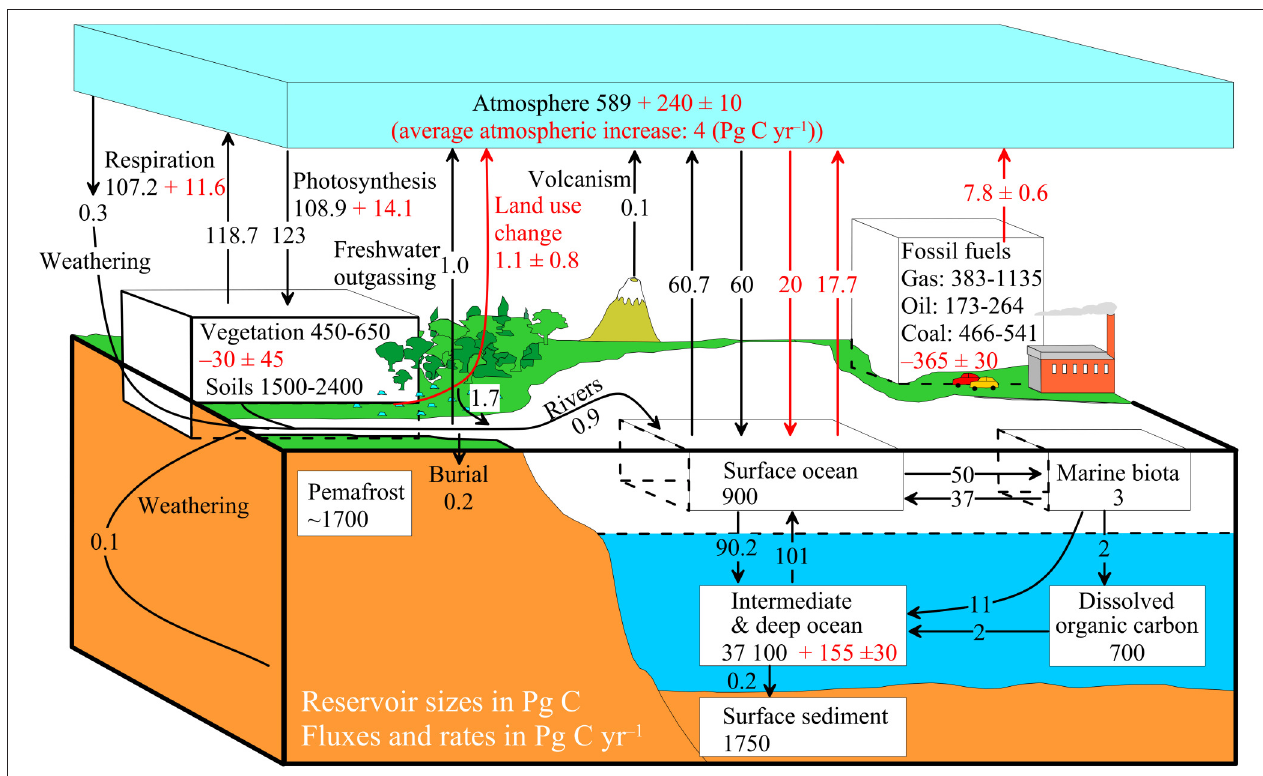
FIGURE 1 | Simplified diagram of the global carbon cycle. Numbers denote reservoir mass, also called “carbon stocks” in Pg C (1 Pg C = 10 15 g C) and annual carbon exchange fluxes (in Pg C yr − 1 ) between the atmosphere and its two major sinks, the land and ocean. Black numbers and arrows indicate reservoir mass and exchange fluxes estimated for the time prior to the Industrial Era, about 1750. Red arrows and numbers indicate annual “anthropogenic” fluxes averaged over the 2000–2009 time period. These fluxes are a perturbation of the carbon cycle during Industrial Era post 1750. Red numbers in the reservoirs represent cumulative changes of anthropogenic carbon over the Industrial Period 1750–2011. The diagram model is taken from Sarmiento and Gruber (2002) and all numbers of stocks and fluxes are reproduced from Ciais et al.